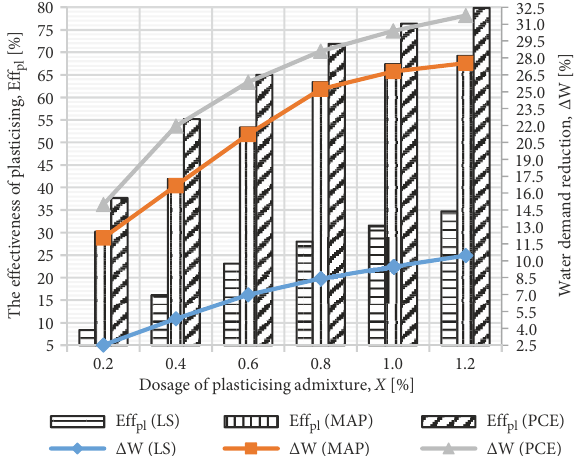
Figure 5. The effectiveness of plasticising of the plasticiser (LS) and the superplasticiser (MAP and PCE) and its influence on de- mand for the paste water, maintaining their equivalent viscosity